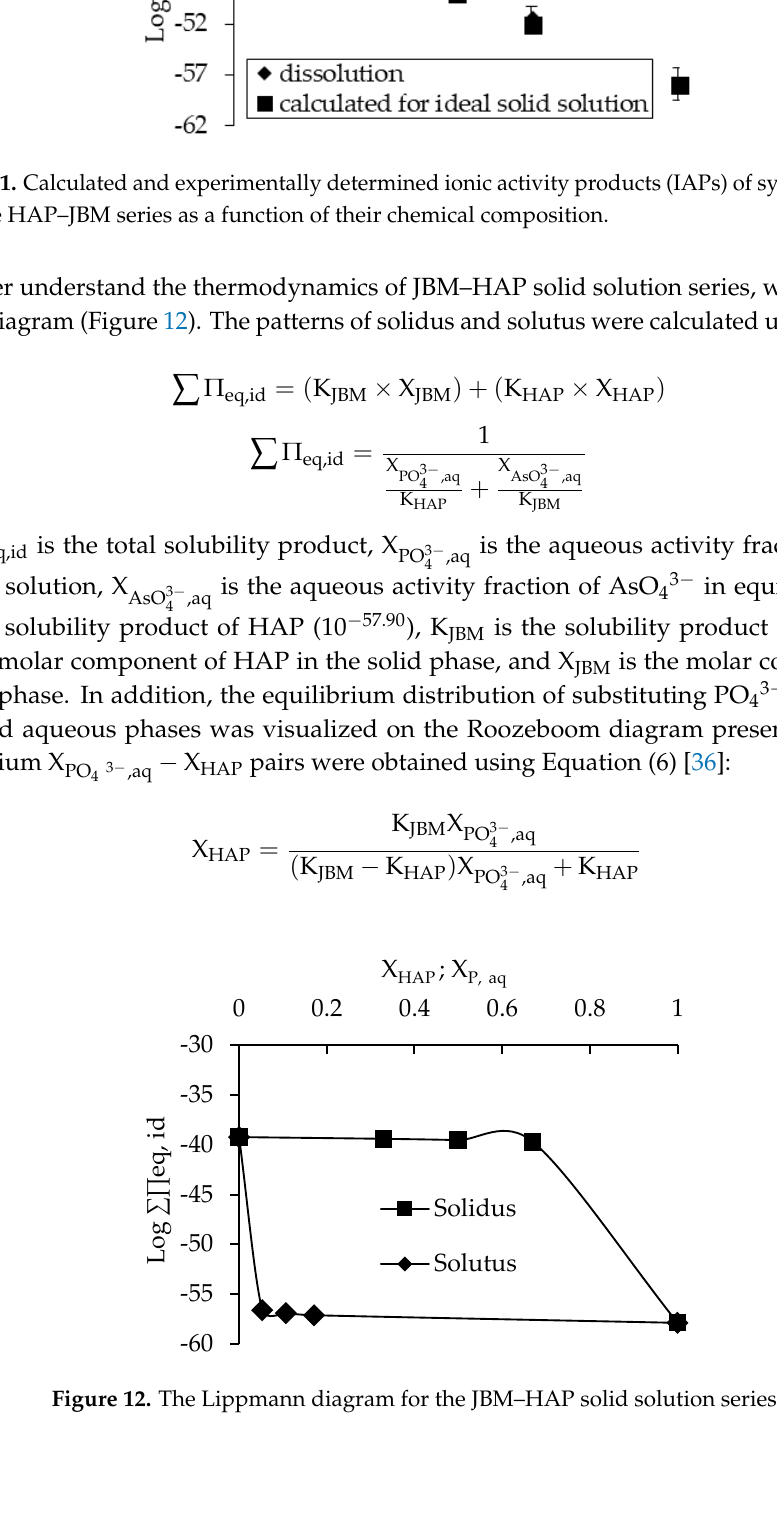
Figure 13. The Roozeboom diagram for the JBM–HAP solid solution series. Similar to other apatites, the temperature variability in the logIAP within JBM–HAP solid solution series was nonlinear. Therefore, since IAP is at equilibrium equal to the solubility product K sp , the results were fit to a nonlinear model (Figure 14) assuming constant heat capacity of the dissolution reaction [39,40]: